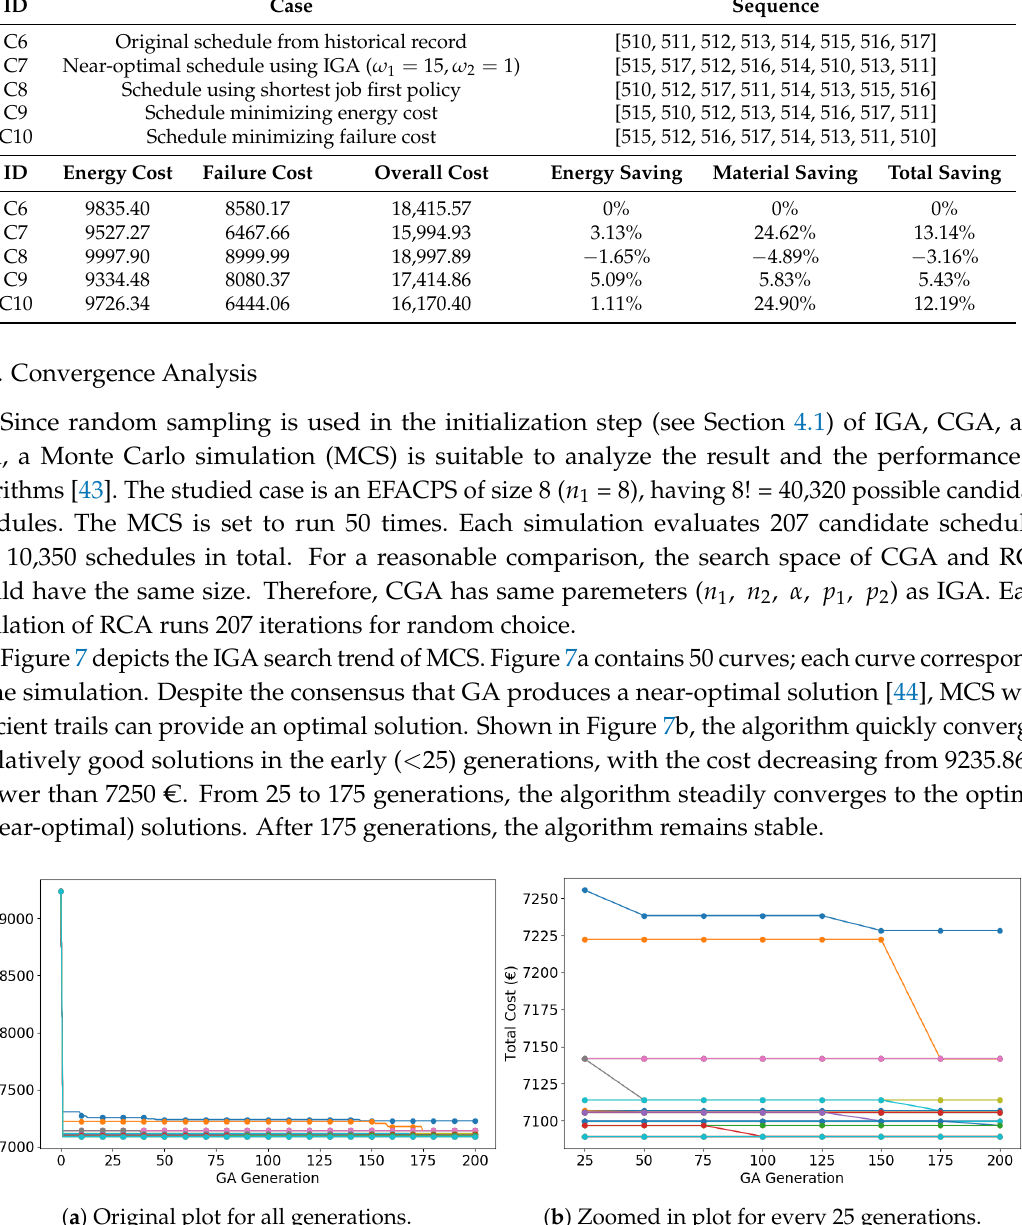
( a ) Original plot for all generations. ( b ) Zoomed in plot for every 25 generations. Figure 7. Total cost as a function of IGA generations (50 curves of 50